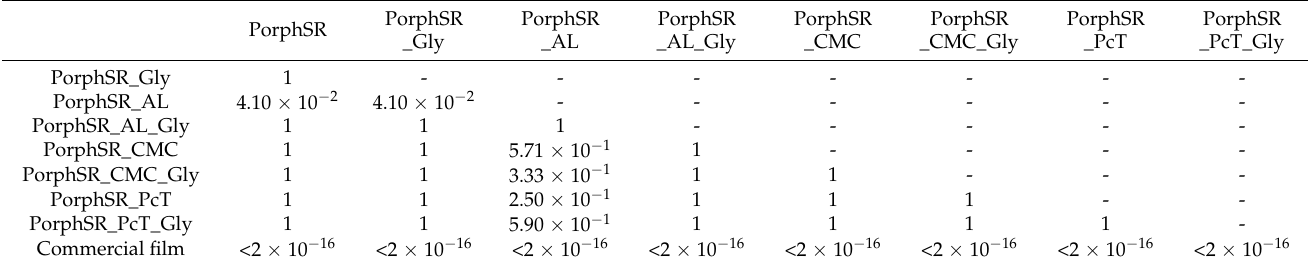
Table A4. Bonferroni pairwise comparison p -values for the different solubilities.